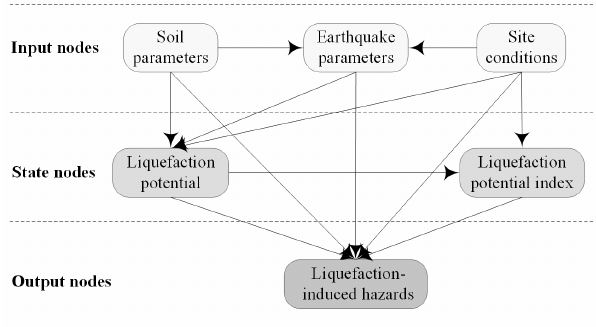
Figure 2. A generic BN for liquefaction-induced